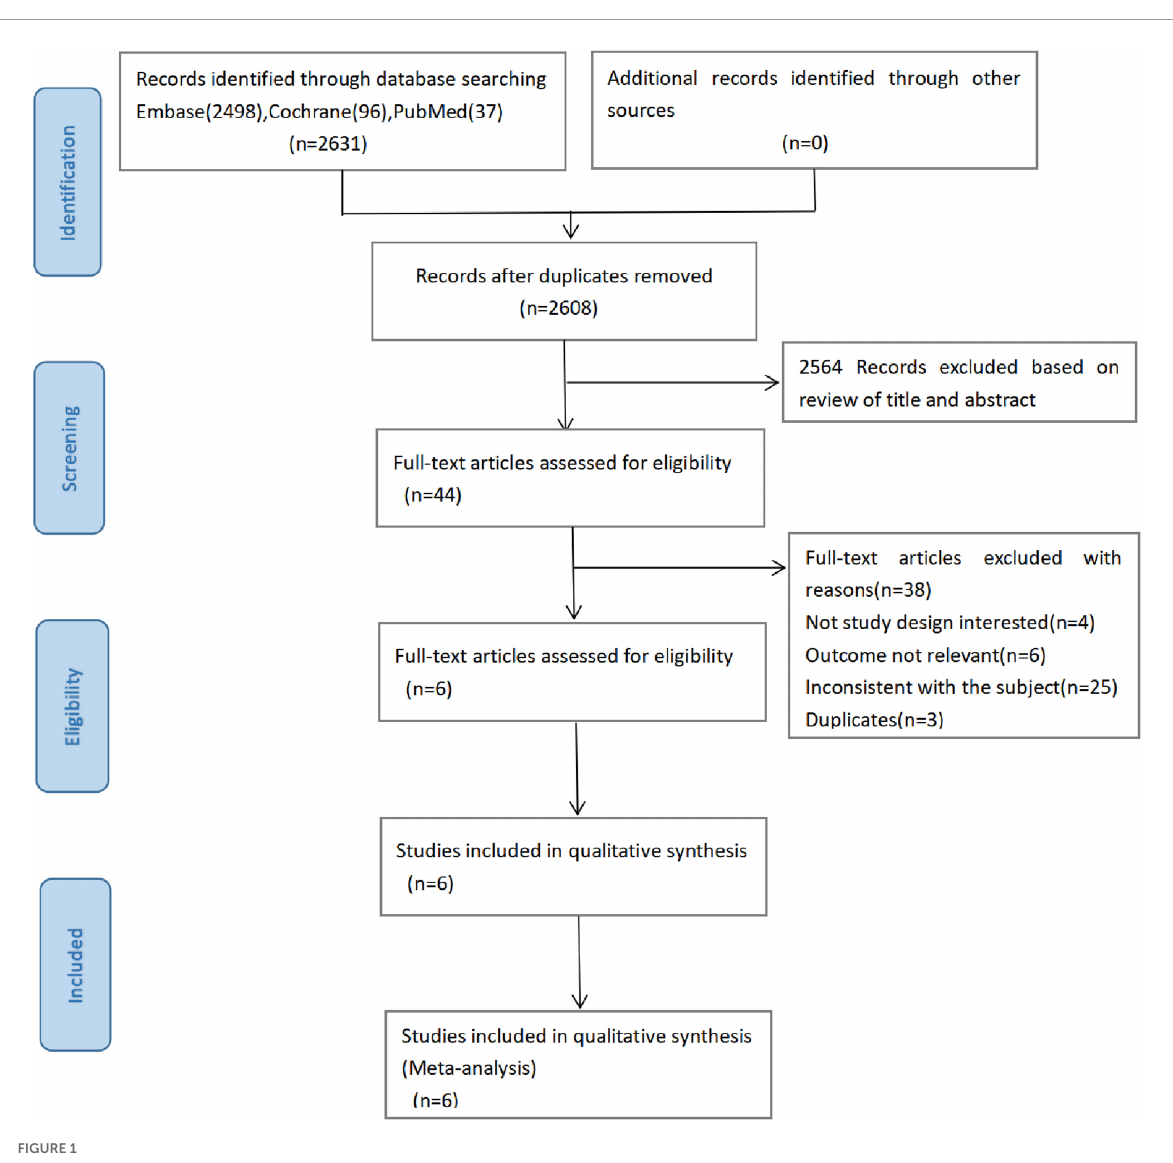
FIGURE1 PRISMA flow chart of literature